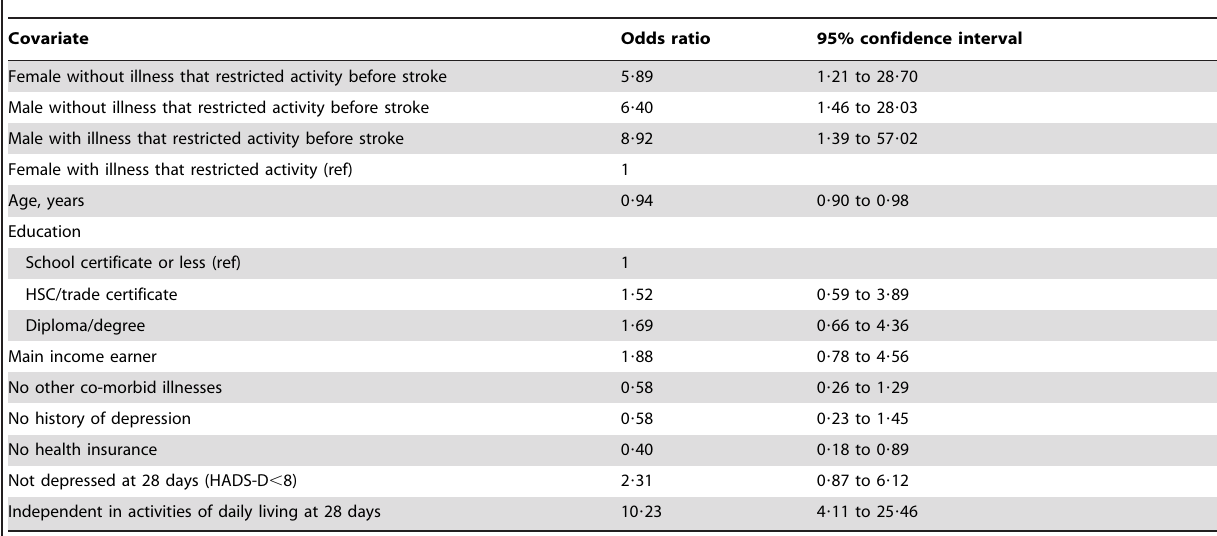
Table 3. Final multivariable model showing variables associated with return to paid employment in the first year after stroke.